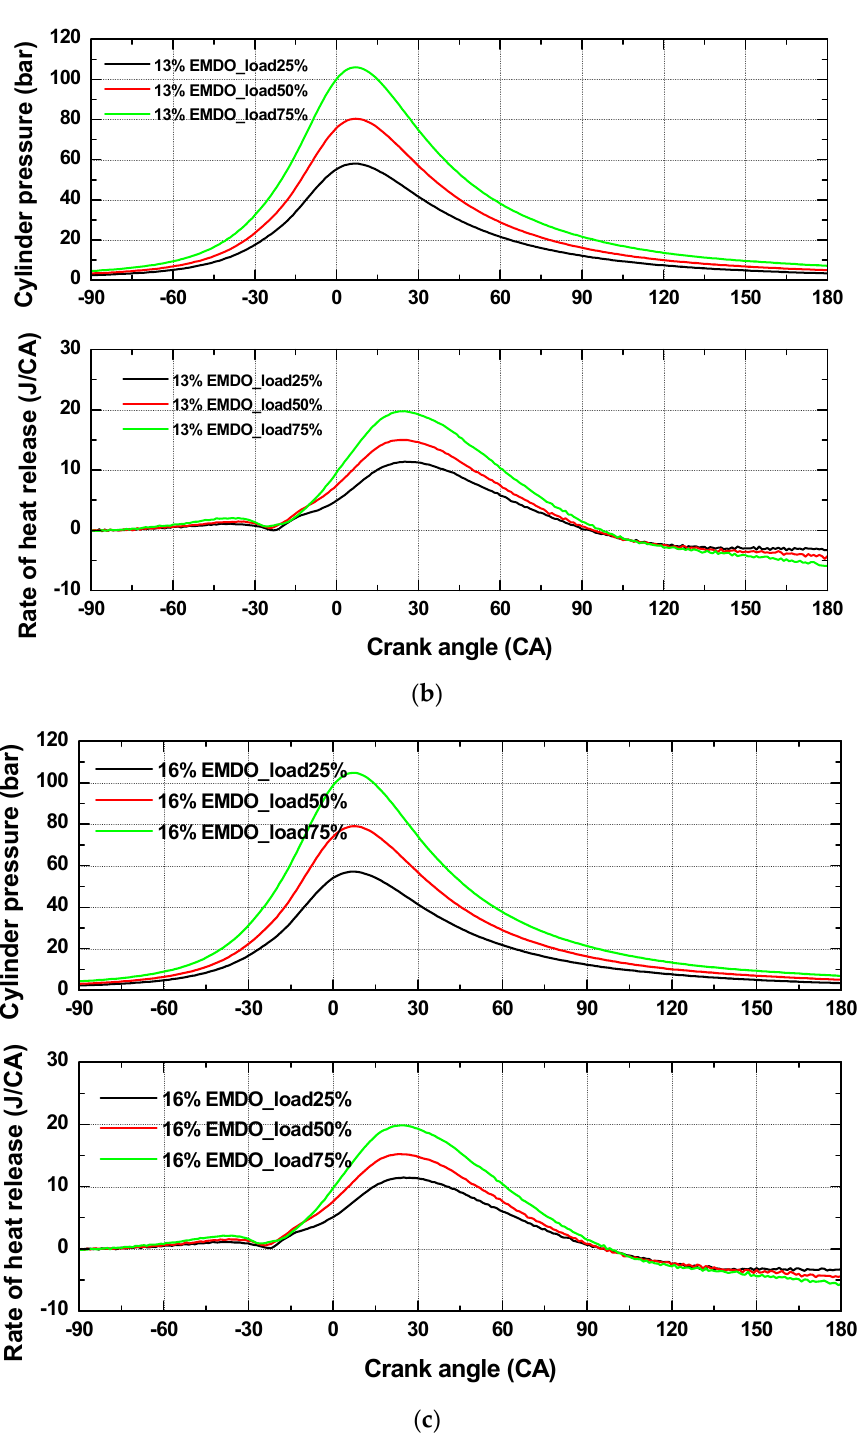
Figure 3. Characteristics of cylinder pressure and heat release of emulsified fuel according to moisture content: (a ) Emulsion ratio 10%; ( b ) Emulsion ratio 13%; ( c ) Emulsion ratio 16%.